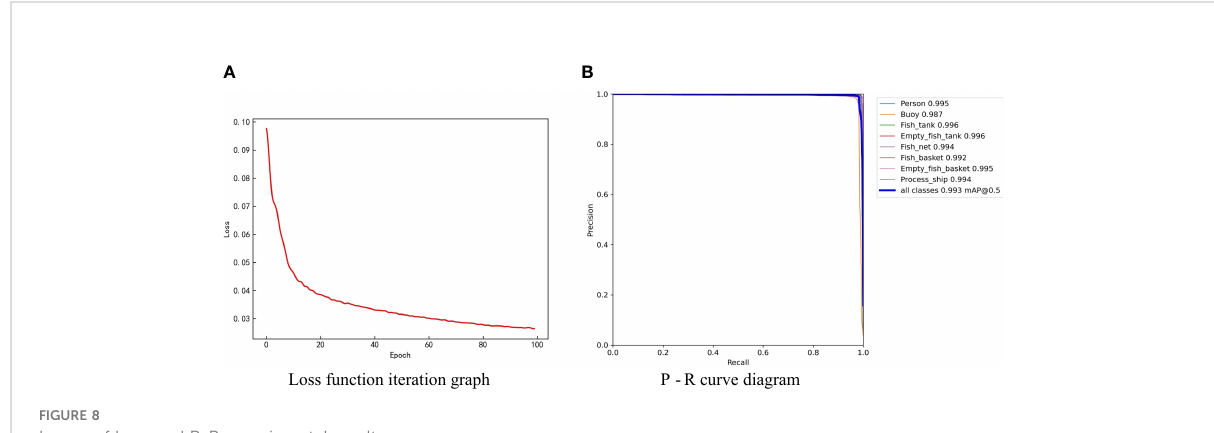
FIGURE 8 Image of Loss and P-R experimental